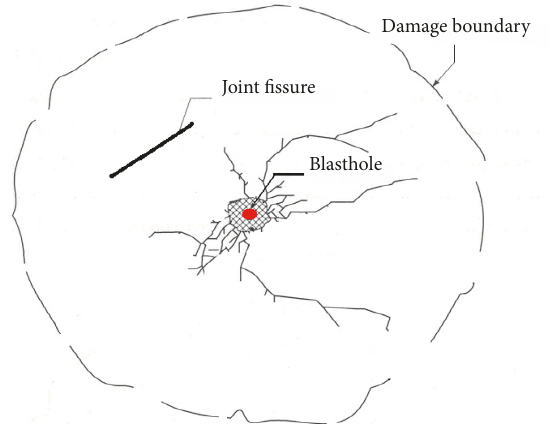
Figure 2: Schematic illustration of rock mass damage induced by single-hole